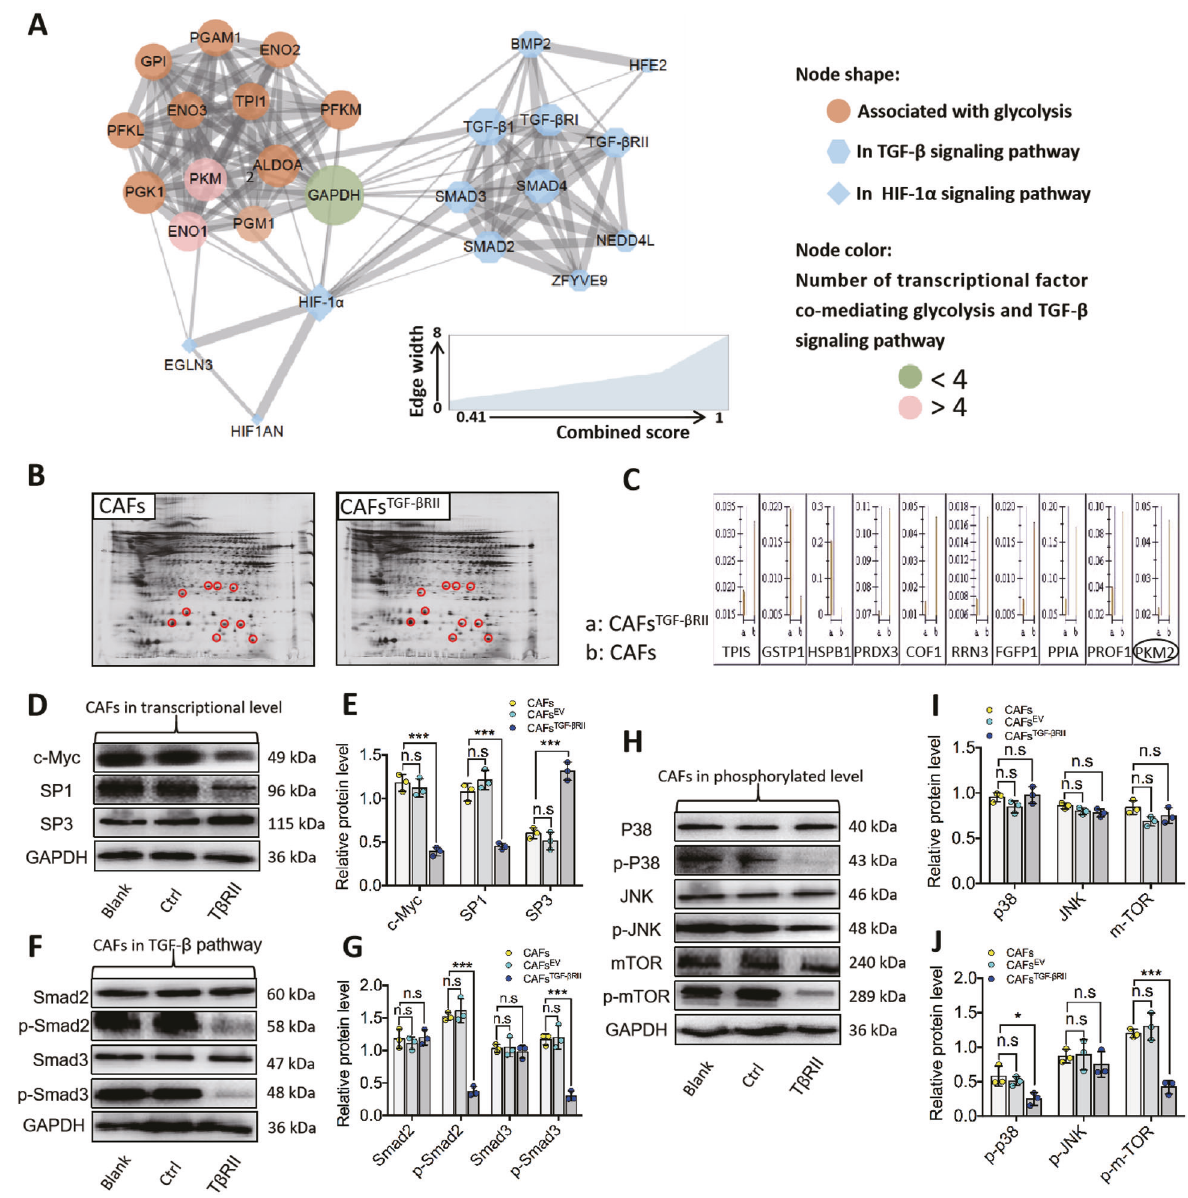
Fig. 4 PKM2 acted as a key regulator in TGF- β RII mediating glycolysis in oral CAFs. A Cytoscape visualization of the protein network in glycolysis with combined analysis of TGF- β and HIF-1 α signaling pathways. Protein – protein interaction network and transcriptional factor co- mediating glycolysis and TGF- β signaling pathway were generated by String and visualized by Cytoscape. PKM2 exhibited a closer relationship with the TGF- β signaling pathway than HIF-1 α in this network analysis. B , C By 2-dimensional electrophoresis (2-DE) staining in proteomics analysis of glycose metabolism, PKM2 was downregulated by the overexpressed TGF- β RII in CAFs (fold change of PKM2 was 2.13021). D , E By western blot (WB), c-Myc, and SP1 were decreased by upregulation of TGF- β RII while SP3 was increased in CAFs TGF- β RII when compared to CAFs EV and CAFs, respectively. F , G Immunoblot showed a reduction of phosphorylated Smad2/3 in CAFs TGF- β RII while no obvious change of total Smad2/3. H – J Immunoblot showed a reduction of phosphorylated P38 and mTOR, however, no obvious difference of total P38, JNK, mTOR, and p-JNK among the groups was observed. The relative protein expression level was quanti fi ed after normalization to GAPDH. n = 3 independent experiments; error bars, mean ± SD; n.s. not signi fi cant, * P < 0.05, *** P < 0.001; t test. cotranscription regulator, PKM2 could increase c-Myc transcription in the total amount of PKM2 levels in cells caused a decrease in through a feedback loop [27]. Our results showed that in the the nuclear PKM2. context of TGF- β RII overexpression, the activation of c-Myc Recently, identi fi ed genes induced by PKM2, include the proto- oncogenes, such as c-Myc and CCND1, and glucose-metabolizing enzymes, such as GLUT1 and LDHA [34]. Indeed, a positive feedback loop between c-Myc and PKM2 is noted. On the one hand, c-Myc promotes the alternative splicing of PKM mRNA to overexpression could downregulate the expression of PKM2 and promote PKM2 expression via hnRNPA1, hnRNPA2, and polypyr- GLUT1, thereby leading to reduce glucose uptake into the nucleus imidine tract binding protein. On the other hand, as a